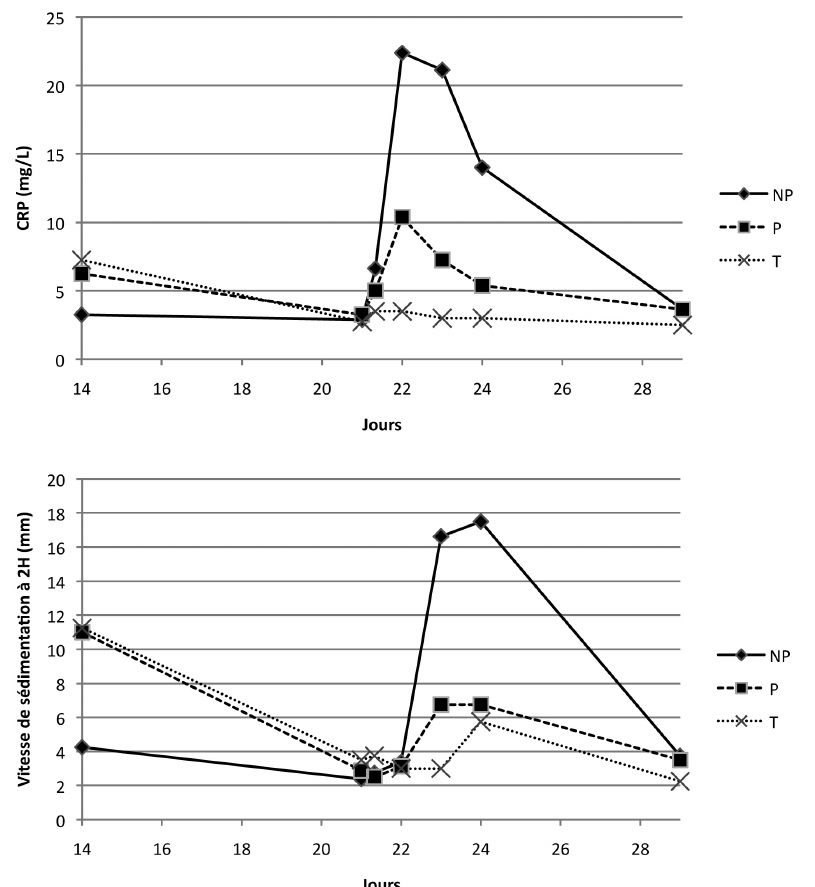
Figure 8. – Vitesse de sédimentation des groupes NP, P et T suite à la seconde